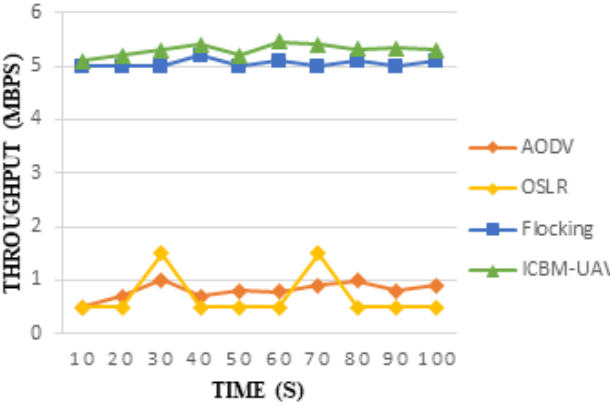
Figure 10. Throughput over time without obstacles.